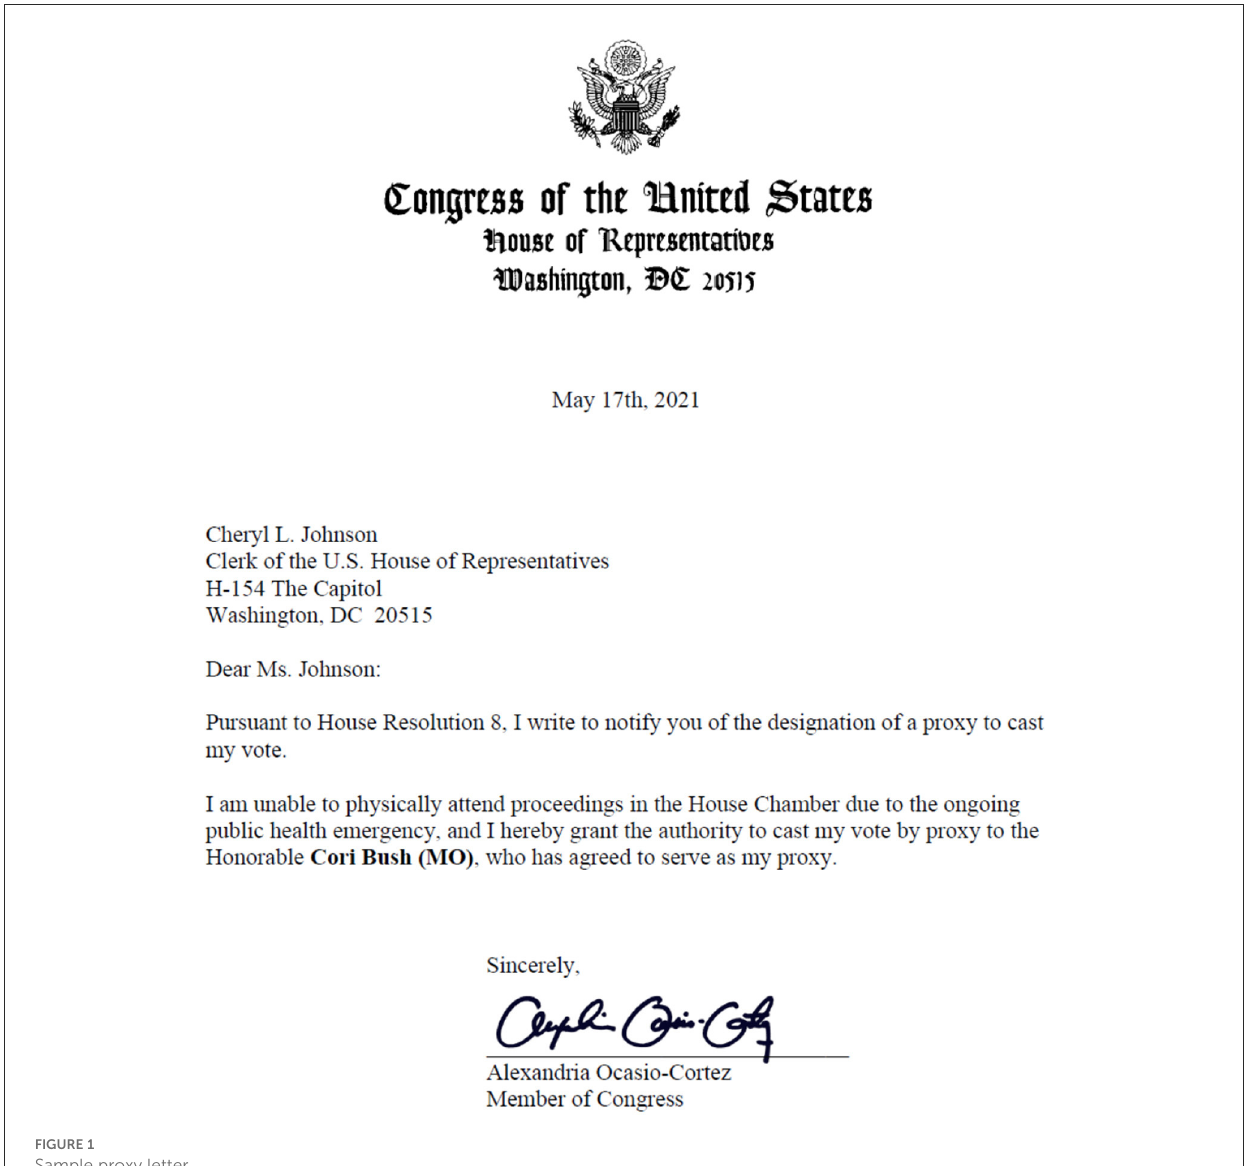
FIGURE1 Sample proxy